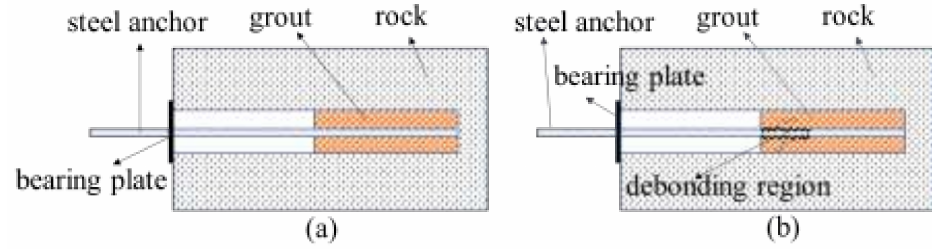
Figure 1. Diagram of anchor in the rock, ( a ) anchor in good condition and ( b ) bond failure anchor. Steel anchor bolts in corrosive environments may degrade in various manners. Stress corrosion cracking (SCC) is one of the main corrosion-induced failure of bolts [1–5]. It